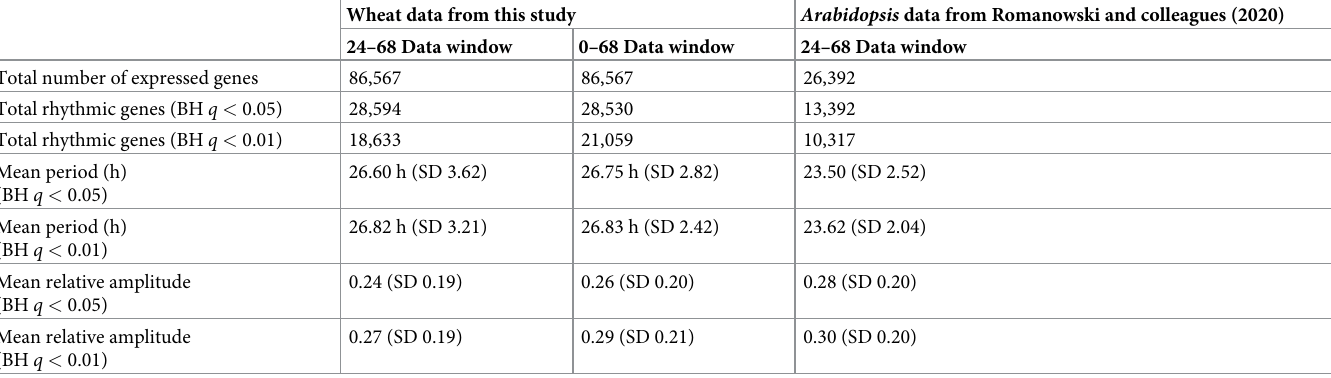
Table 1. Numbers of rhythmic genes at (BH q < 0.05 or BH q < 0.01) in Arabidopsis and wheat identified using Metacycle BH q -values. Wheat data from this study Arabidopsis data from Romanowski and colleagues